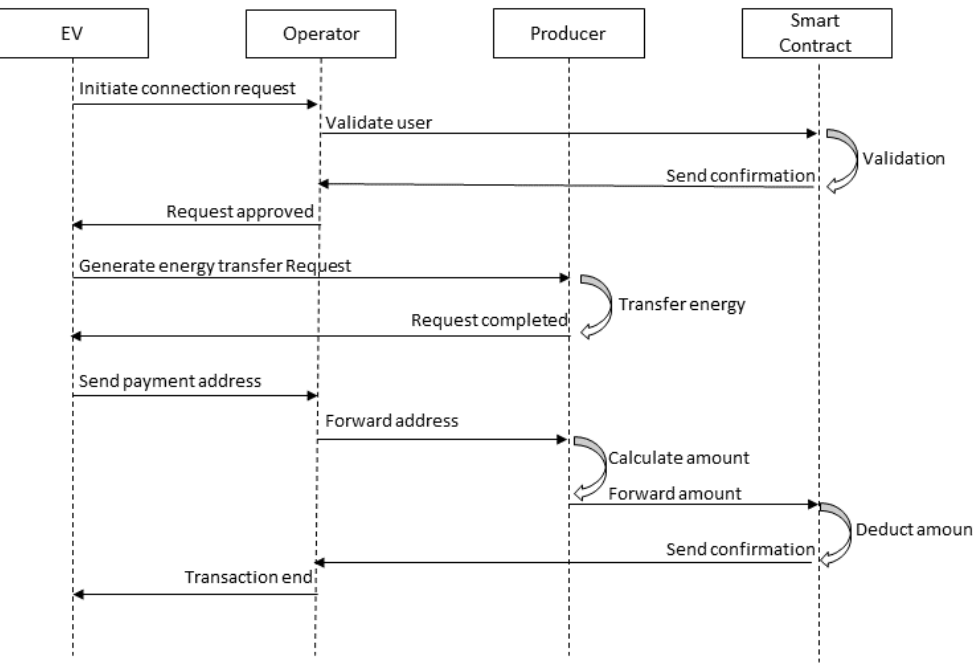
Figure 9. Sequence diagram for transaction using smart contract.